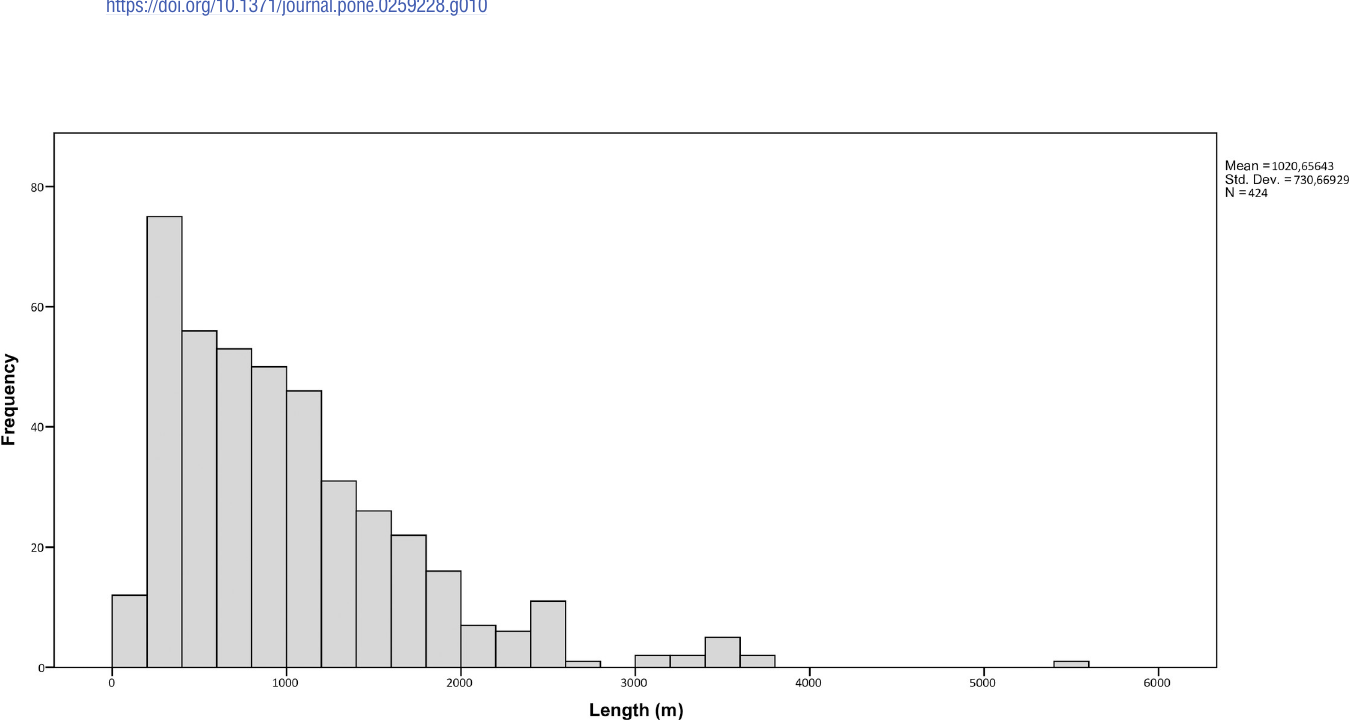
Fig 11. Histogram showing the length range of qanats .